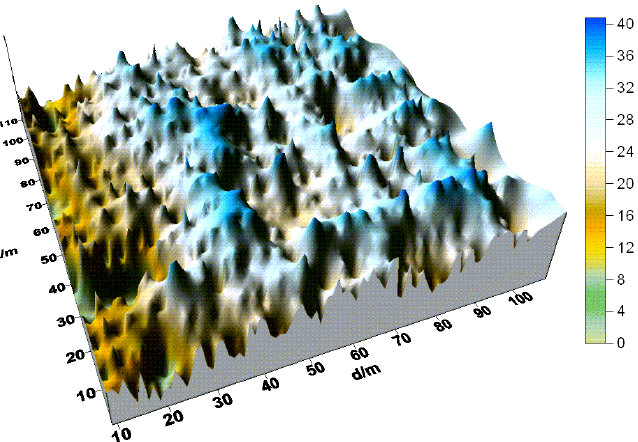
Figure 9. Working resistance distribution diagram of the hydraulic support on working face.